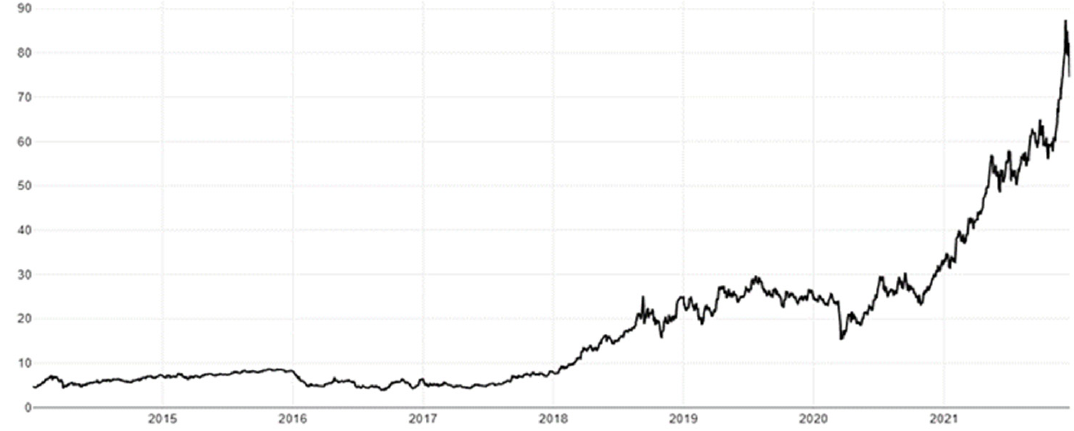
Figure 1. CO 2 emissions allowance prices between 2015 and 2022 (EUR/tCO2) [18].